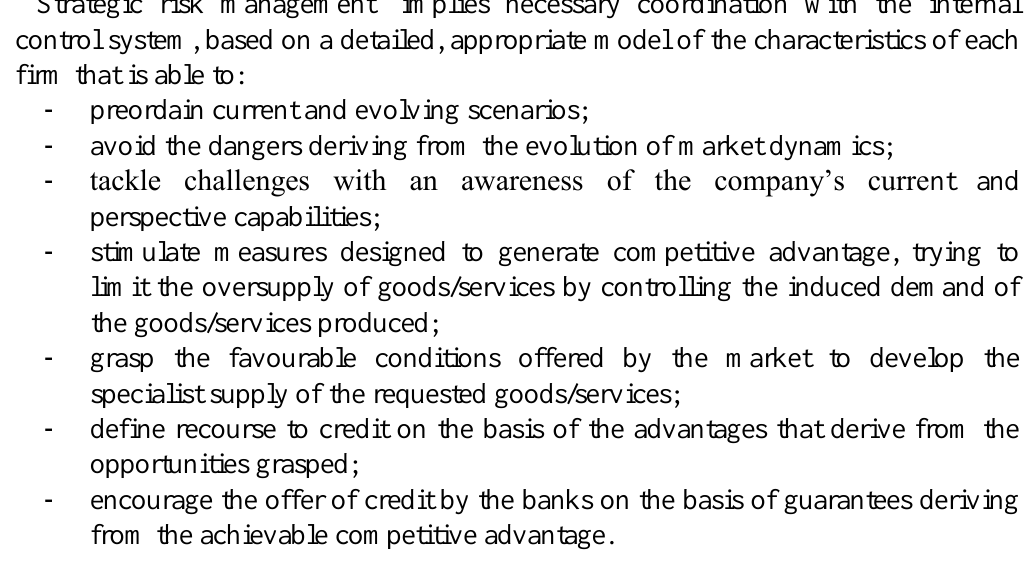
Figure 1: Monitoring Risks in Relations with